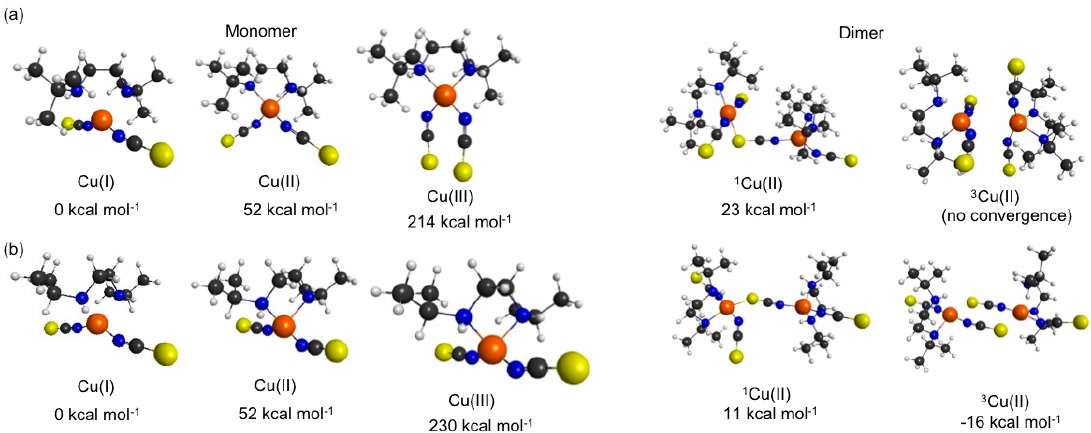
Figure 6. Geometries associated with the ground state minima of ( a ) 5 and ( b ) 4 . The dimer geometries are relative to the energy of the Cu(I) + Cu(I) monomer asymptote at infinite separation.